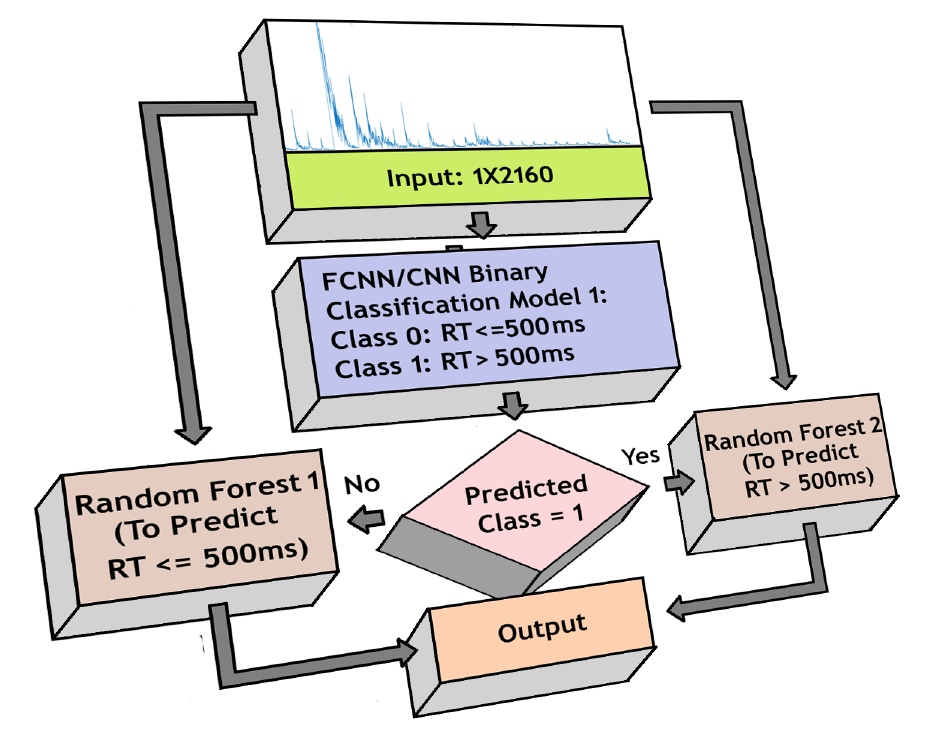
Figure 7. Model for regression-based reaction time (RT) estimation using FCNN/CNN architecture and Random Forest